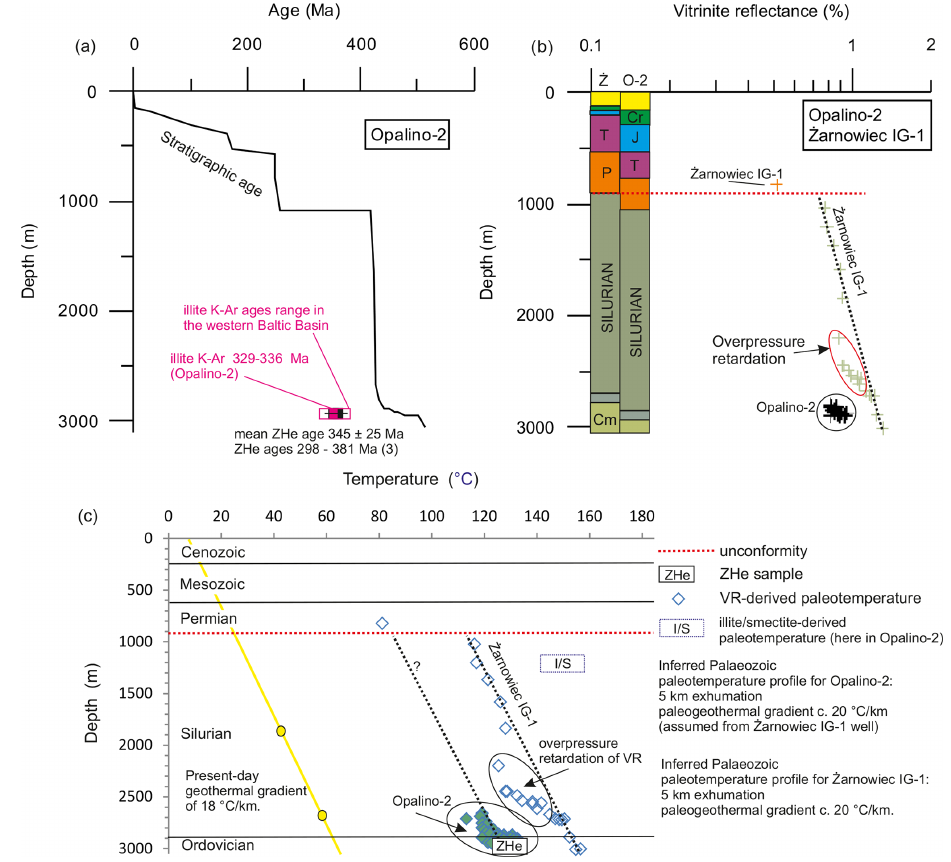
Figure 6. Opalino-2 and ˙Zarnowiec IG-1 borehole data (western part of the Baltic Basin). (a) ZHe ages are similar to K-Ar ages (Kowalska et al., 2019) and are younger than a depositional age of sample. (b) Opalino-2 (O-2) and ˙Zarnowiec IG-1 (˙Z) vitrinite reflectance (VR) profiles. The approach by Petersen et al. (2013) was used to recalculate reflectance measurements on vitrinite-like macerals from the lower Paleozoic strata into a standard vitrinite reflectance scale. Since the Opalino-2 VR profile is too short to define gradient and estimate exhumation, the adjacent well (˙Zarnowiec IG-1 VR) was used. The profile clearly shows overpressure retardation of thermal maturity, which occurs within the mudstone/claystone dominated Silurian section in most wells in the western Baltic Basin. The ˙Zarnowiec IG-1 VR profile shows a break across the Silurian–Permian unconformity as a VR value is 0.5% in Permian sediments. (c) Paleotemperature profile of the Opalino-2 (green diamonds) and ˙Zarnowiec IG-1 (open blue diamonds) wells. The yellow line represents present-day geothermal gradient based on the corrected bottom hole temperature data (Górecki et al., 2006a, b). The paleogeothermal gradient of 20 ◦ Ckm − 1 in the Opalino-2 well, comparable to the present-day gradient and the paleogradient in the ˙Zarnowiec IG-1 well, gives an exhumation of ≈ 4–5km similar to that in the ˙Zarnowiec IG-1